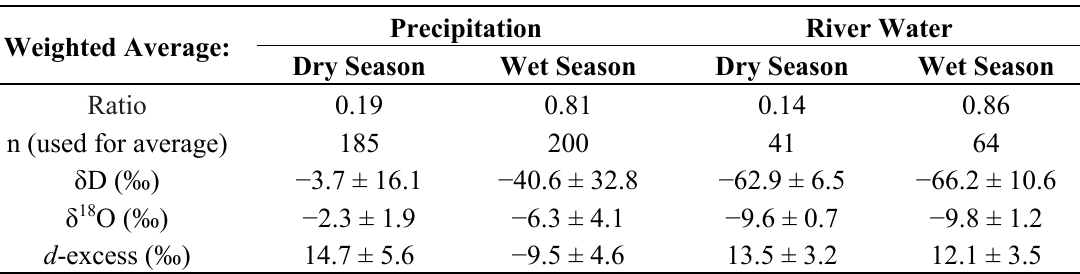
Table 2. Precipitation and river water weighted average δ D, δ 18 O and d -excess and their standard